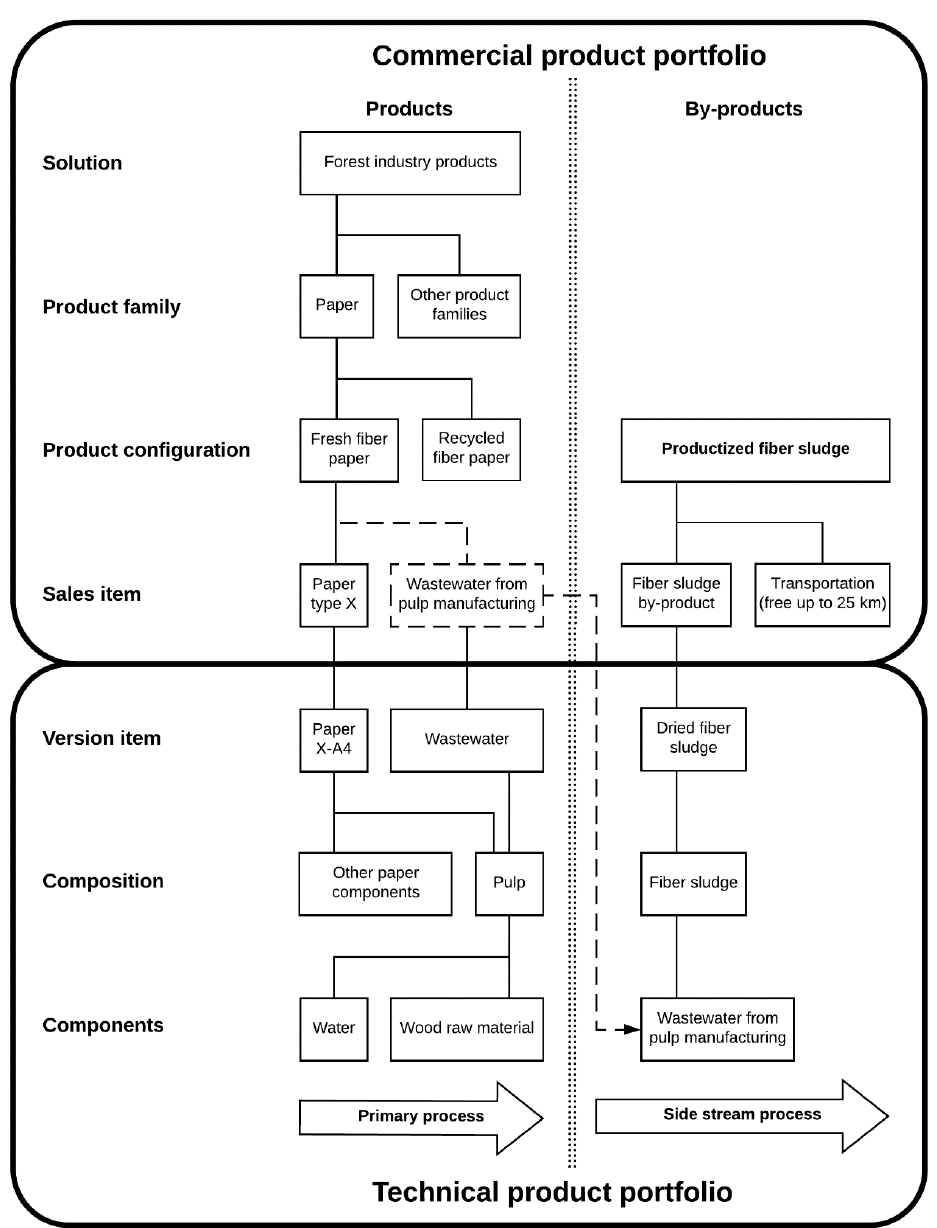
Figure 2. The product portfolio of Stora Enso Oulu with respect to aspects essential to productization of fiber sludge. Wastewater from primary process is an input to side stream process and as such is marked as a sales item of the primary process. If the side stream process were to be operated